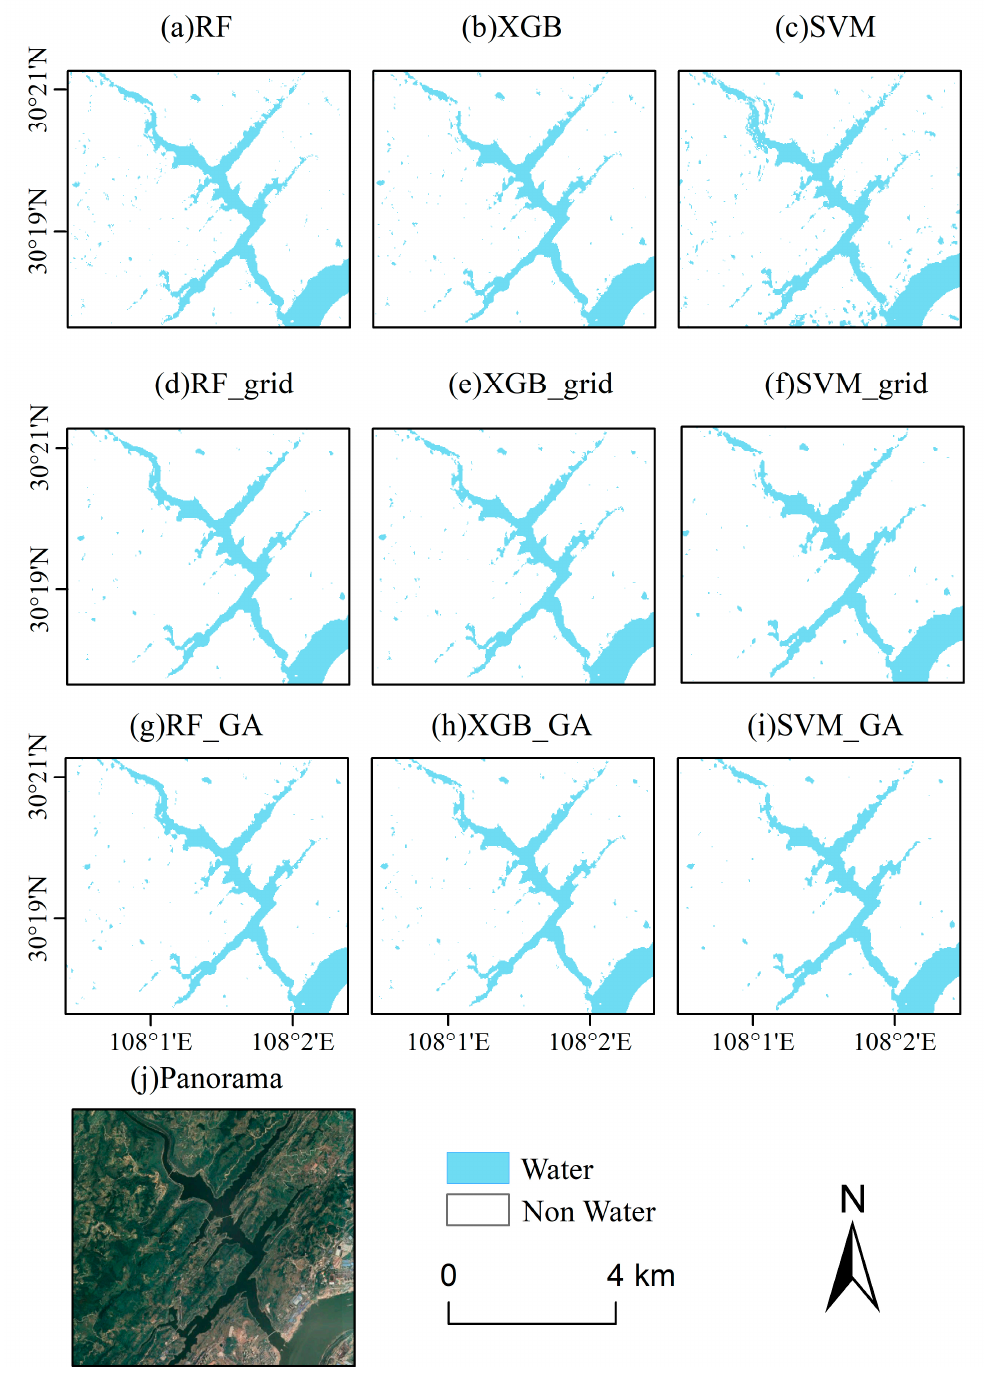
Figure 7. Maps of water surface produced by ( a ) RF, ( b ) XGB, ( c ) SVM, ( d ) RF optimized by grid search, ( e ) XGB optimized by grid search, ( f ) SVM optimized by grid search, ( g ) RF optimized by grid search, ( h ) XGB optimized by grid search, and ( i ) SVM optimized by grid search. ( j ) Panorama data of Huangjin River.